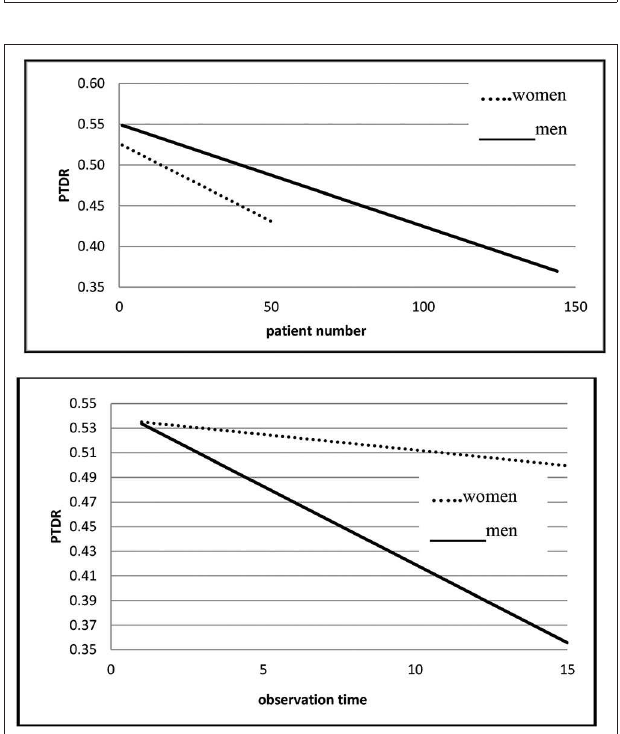
FIGURE 2 | PTDR relationship for women and men.